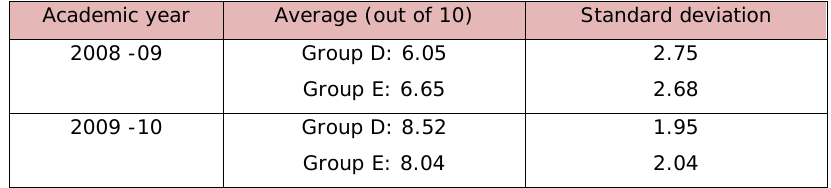
Table 8. “Overall assessment of the methodology by the students”. Source: